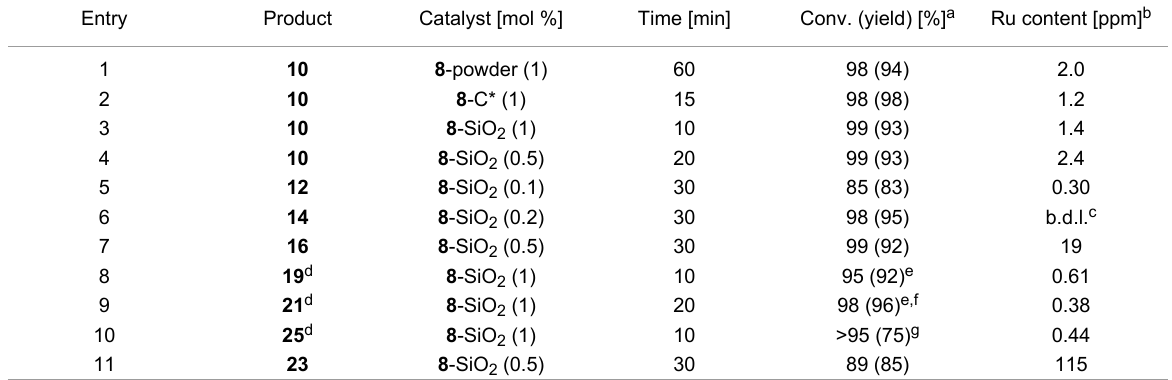
Table 2: Results of olefin metathesis conducted in toluene, 80